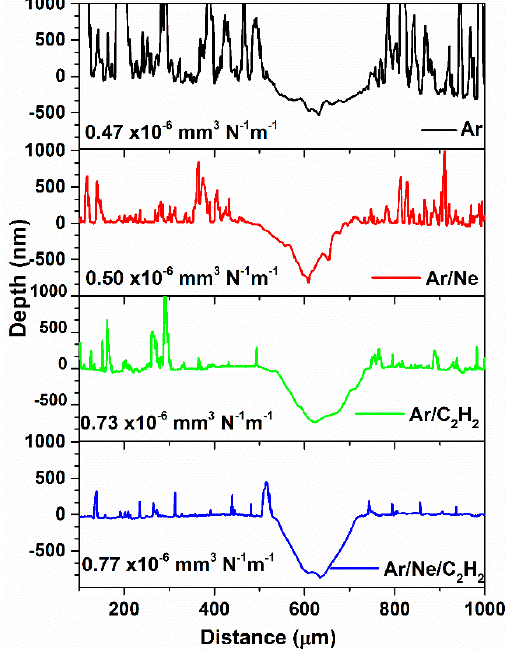
Figure 8. Wear track profiles on four coatings on 304 L steel, obtained in the conditions described in Table 1 and Figure 1.